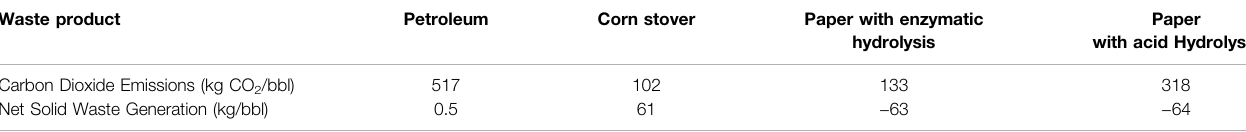
TABLE 9 | Carbon dioxide emissions and solid waste production for corn stover to jet fuel and paper to jet fuel processes.